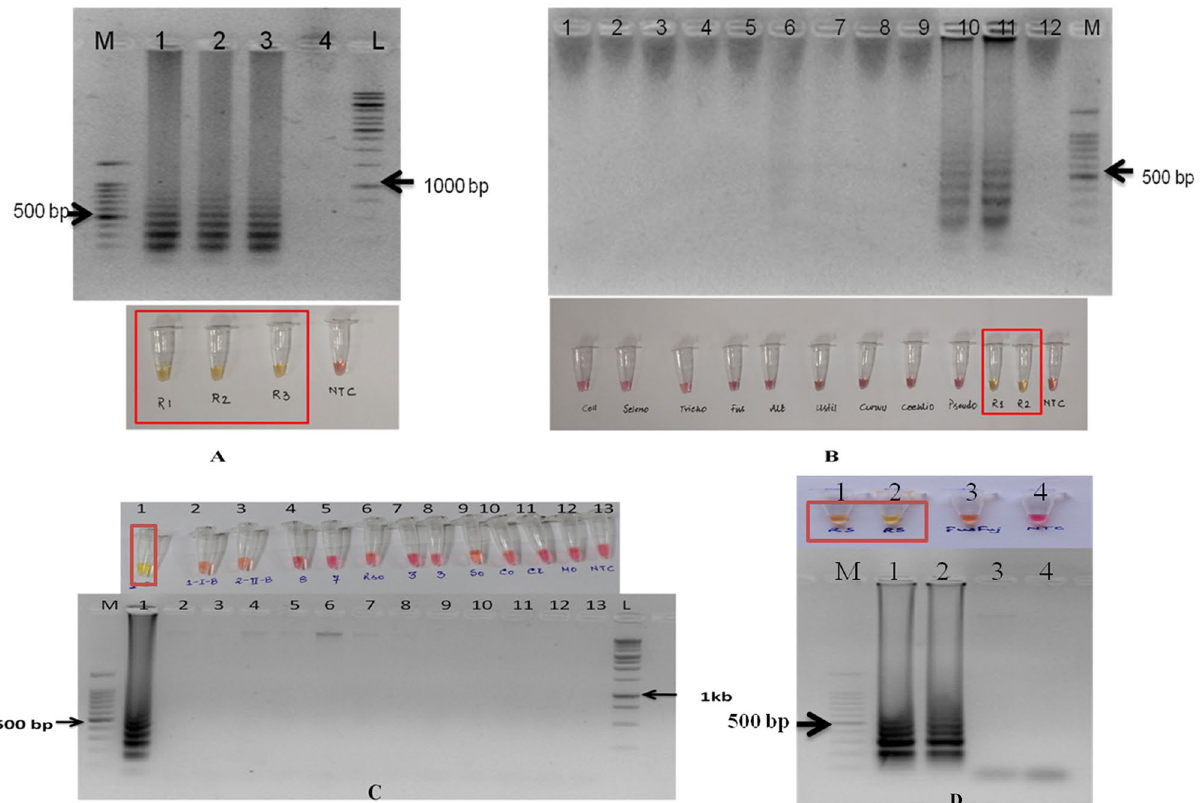
Figure 4. Optimization and validation of LAMP assay. Yellow colour indicated a positive reaction while red/ pink colour indicated no reaction. ( A ) LAMP assay optimized with pure fungal isolates with no template control. M: 100 bp (Promega); 1: R. solani AG-1 IA isolate PURS1; 2: R. solani AG-1 IA isolate PURS2 3: R. solani AG-1 IA isolate PURS3; 4: No Template control; L: 1 kb (Generuler). [upper panel: gel photograph; lower panel: colorimetric reactions in PCR tubes] ( B ) Specificity assay of the LAMP assay. L: 1 kb (Generuler); 1: Colletotrichum capsici isolate CABI-063597; 2: Sclerotium rolfsii ; 3: Trichoderma asperellum; 4: Fusarium oxysporum ; 5: Alternaria alternata ; 6: Ustilaginoidea virens ; 7: Curvularia prasadii ; 8: Cochiliobolus tuberculatus ; 9: Pseudomonas plecoglossicida 10: R. solani AG-1 IA isolate PURS1; 11: R. solani AG-1 IA isolate PURS2; 12: No Template control; M: 100 bp (Promega). [upper panel: gel photograph; lower panel: colorimetric reactions in PCR tubes] ( C ) M: 100 bp (Promega); 1: R. solani AG-1 IA isolate PURS1; 2: R. solani AG-1 IB 3: R. solani AG 2–2 IIIB; 4: R. solani AG-8; 5: R. solani AG-7; 6: R. oryzae‑sativae 7: R. solani AG-3; 8: R. solani AG-3; 9: Sarocladium oryzae ; 10: Curvularia oryzae ; 11: Curvularia lunata ; 12: Magnaporthe oryzae ; 13: No template control; 14: 1 kb ladder (Promega) [upper panel: colorimetric reactions in PCR tubes; lower panel: gel photograph] ( D ) M: 100 bp (Promega); 1: R. solani AG-1 IA isolate PURS1; 2: R. solani AG-1 IA isolate PU RS14; 3: Fusarium fujikuroi isolate RPF19; 4: No template control [upper panel: colorimetric reactions in PCR tubes; lower panel: gel